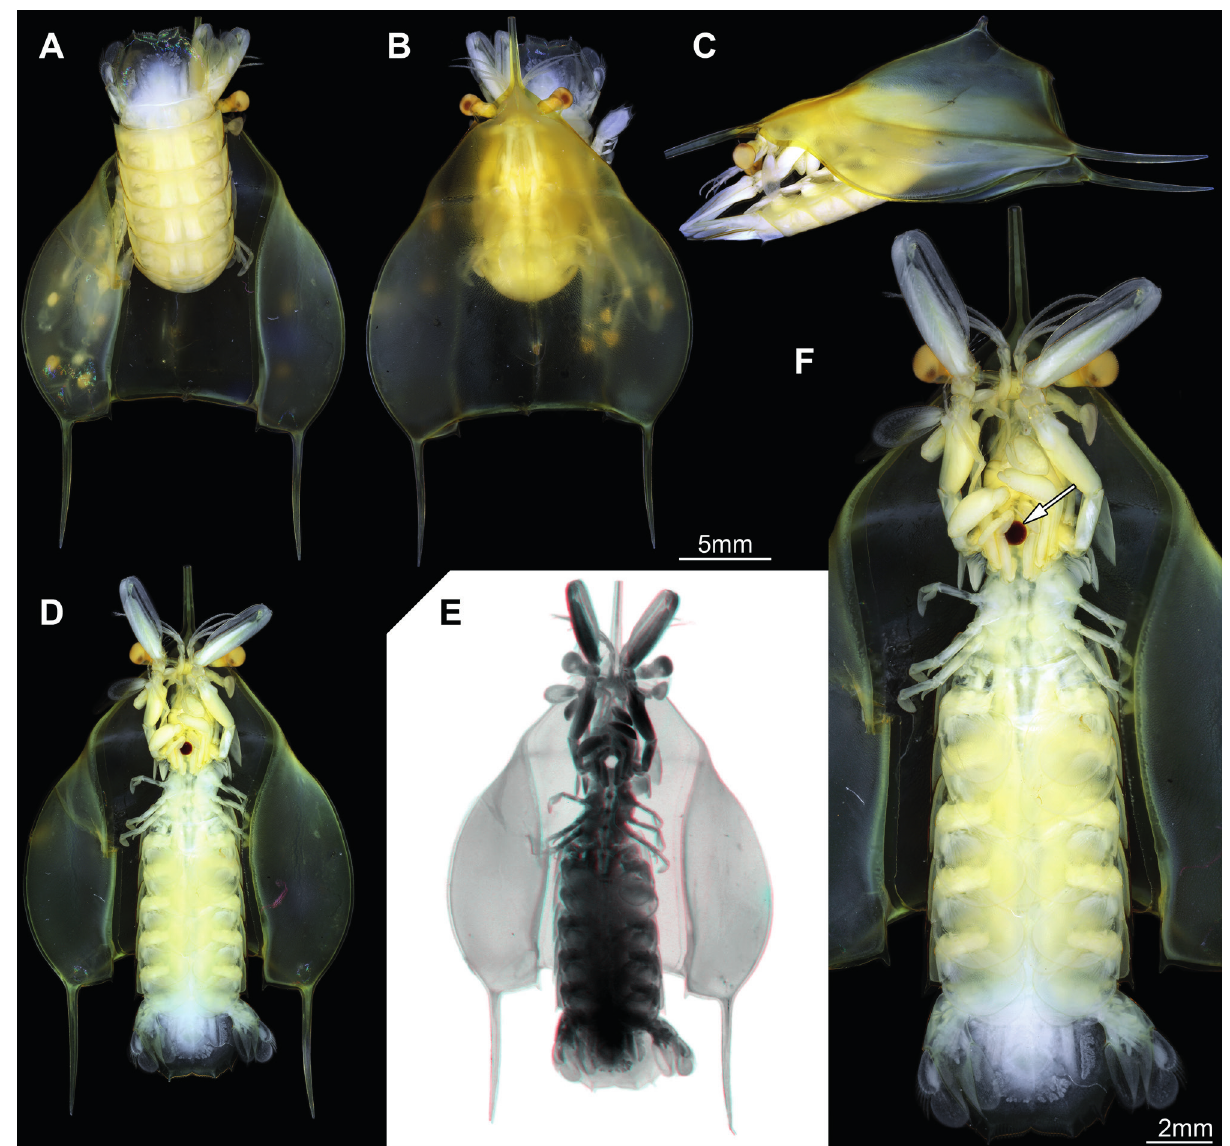
Figure 4. New morphotype 2, “spiny balloon”; ZMUC-CRU-8665. A–C. Original condition as found in the jar; the pleon is bend far anteriorly within the “pockets” of the shield several small alima larvae are trapped. A. Ventral view. B. Dorsal view. C. Lateral view. D–E. Repositioned, alima larvae removed; ventral view. D. Overview. E. Red-cyan stereo-anaglyph image. F. Close up on central body region. Arrow marks possible